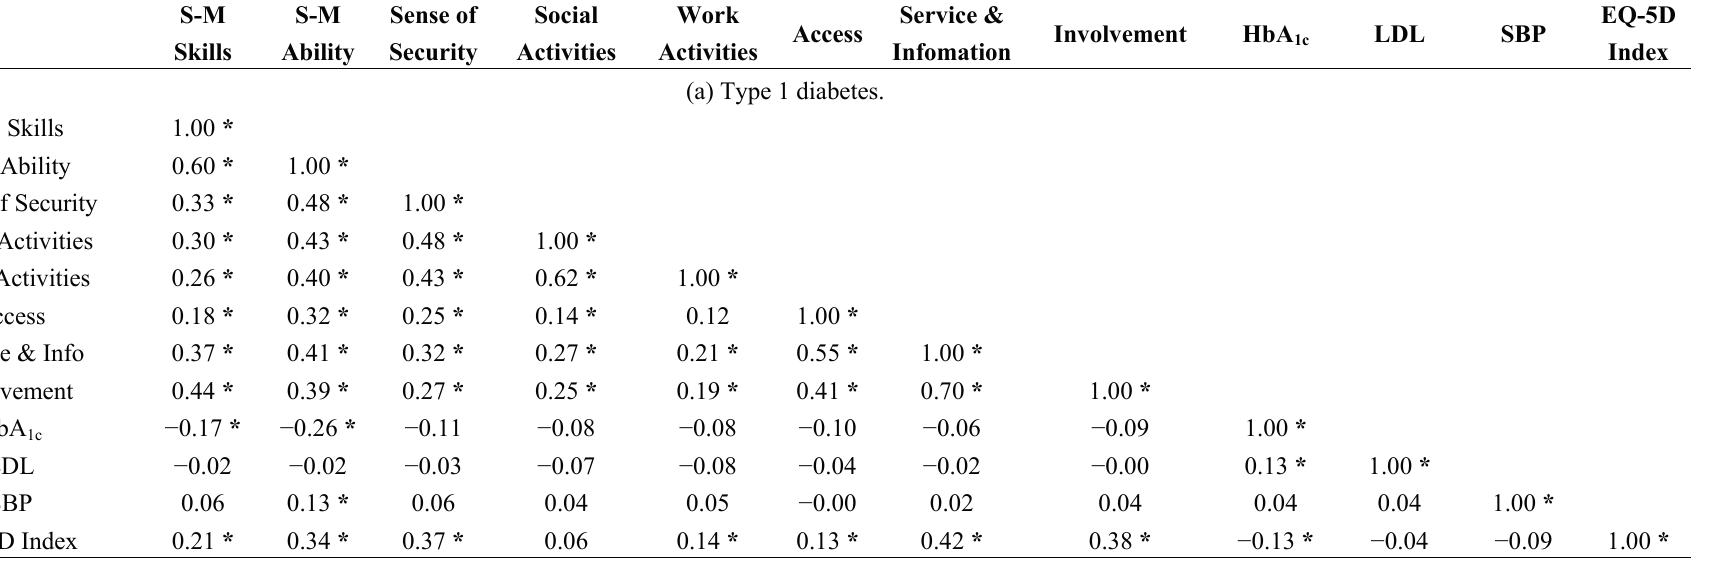
Table 2. Correlations (Spearman’s rho) between latent variables, risk factors, and EQ-5D Index. Service & S-M S-M Sense of Social Work Access Involvement HbA Skills Ability Security Activities Activities Infomation